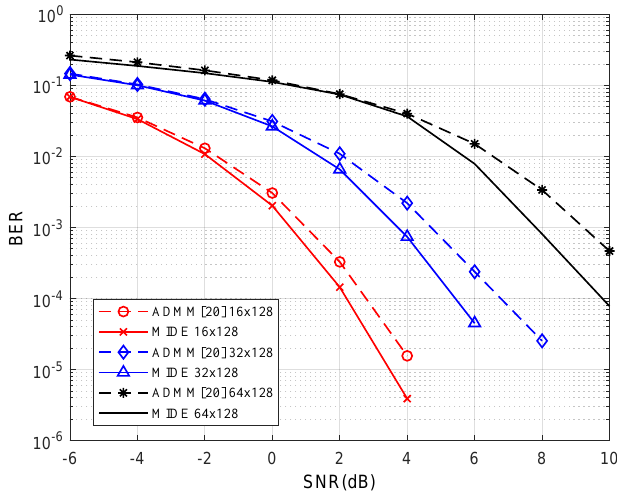
Figure 4. BER performance comparison of the conventional ADMM and the proposed algorithm.